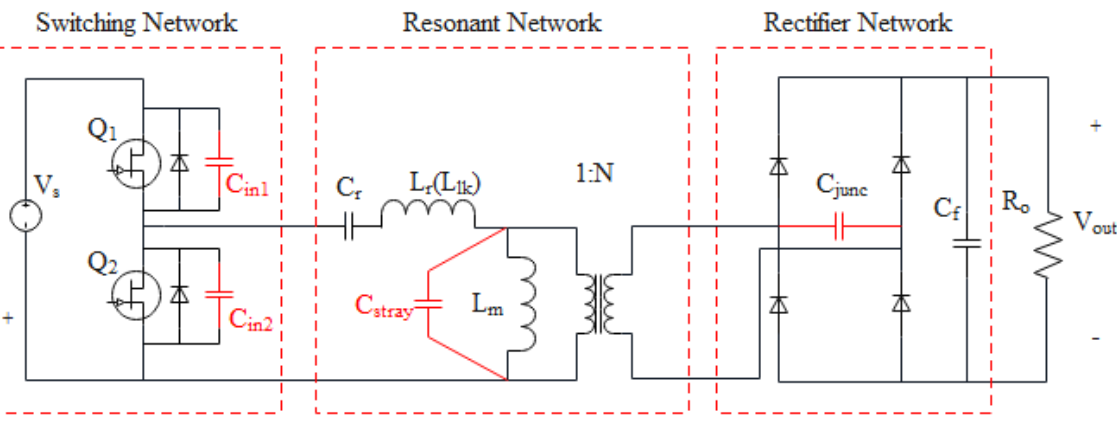
Figure 1. LLC resonant converter with parasitic components.